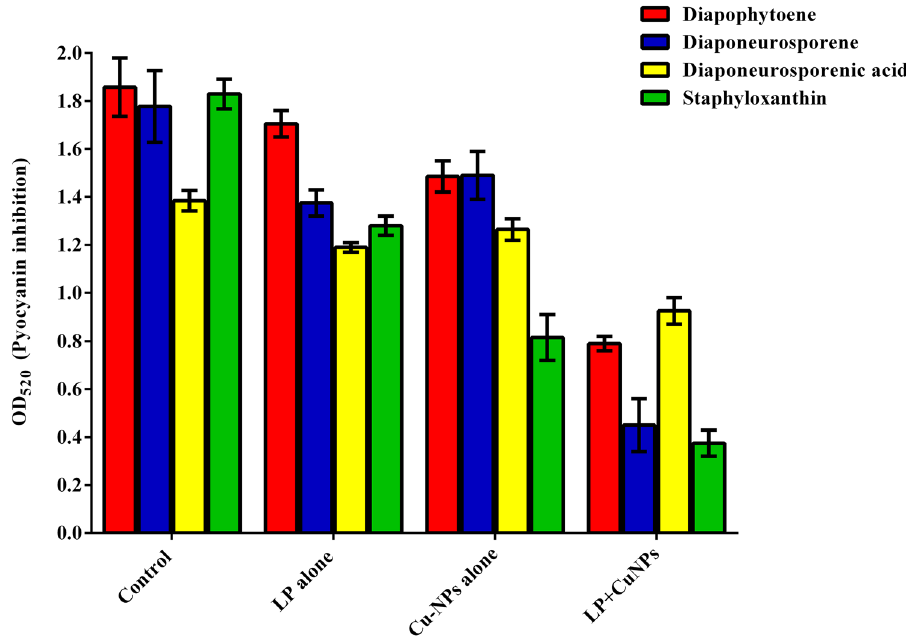
Figure 8. Inhibition of Staphyloxanthin. All data points represent the mean ± SD from at least three independent